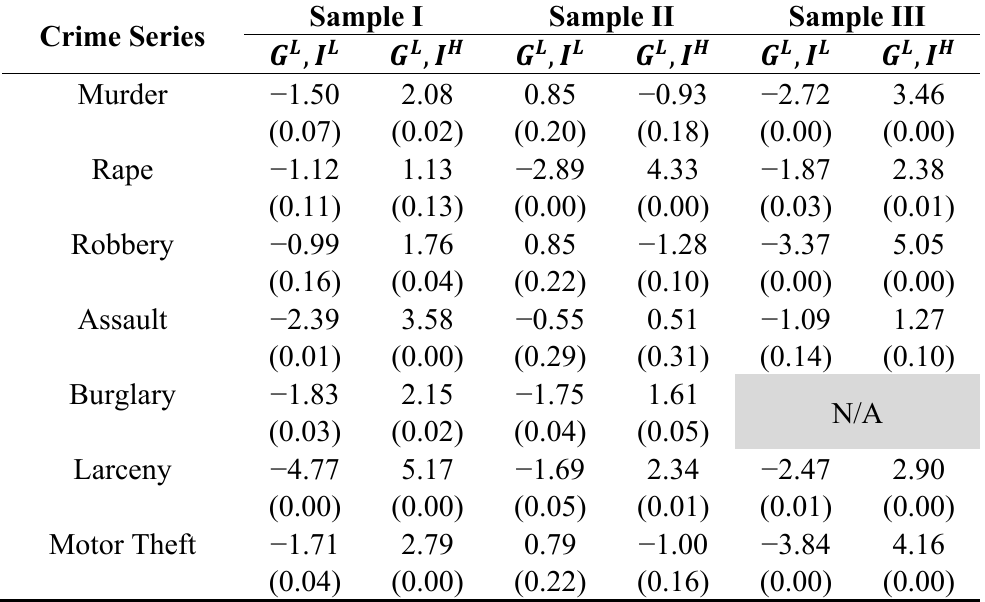
Table 3. Sub-sample analysis of convergence in